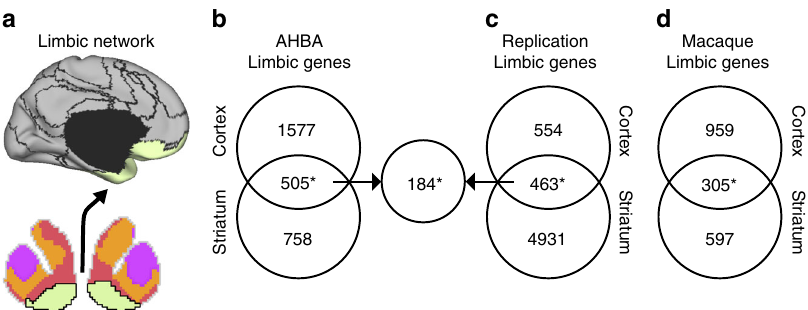
Fig. 8 Limbic network-biased genes are consistent in independent human and non-human primate datasets. a Schematic illustrating the limbic cortico- striatal network displayed on a bi-hemispheric cross-section of the striatum and the lateral surface of the left hemisphere. b Among the AHBA data, 505 genes displayed overlapping positive differential expression for both limbic striatum and limbic cortex (hypergeometric p ≤ 0.001). c Among the GTEx and Brainspan replication data, 463 genes displayed overlapping positive differential expression for limbic striatum and limbic cortex, 184 of which overlapped with the AHBA limbic network gene set (ps ≤ 0.001). d In macaques, 305 genes displayed overlapping positive differential expression for limbic striatum and limbic cortex, 93 of which overlapped with the AHBA limbic network gene set (ps ≤ 0.001). * p AHBA mRNA probe selection . Before tissue dissection, donor brains underwent anatomical MRI scanning and alignment to MNI space by the Allen Institute. Available samples ( n = 4 left hemisphere only, n = 2 both left and right hemi- spheres) were prepared for microarray expression analyses by the Allen Institute via macro-dissection for cortical areas or laser dissection for subcortical regions 29 . For additional information on structural imaging data as well as microarray pre- processing and normalization procedures, refer to the AHBA technical white paper (help.brain-map.org/display/humanbrain/Documentation). A total of 58,692